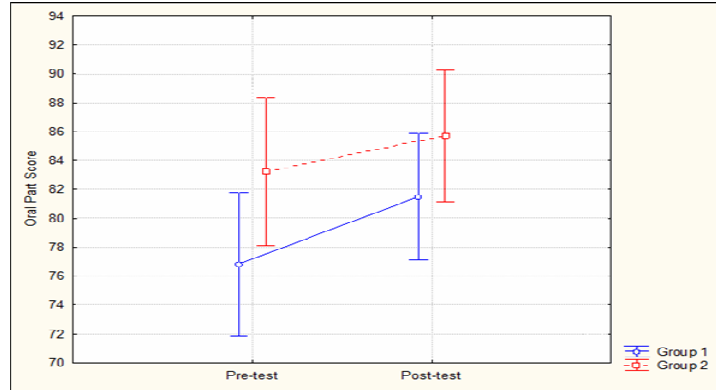
Figure 2. Oral Part pre-test and post-test scores for both